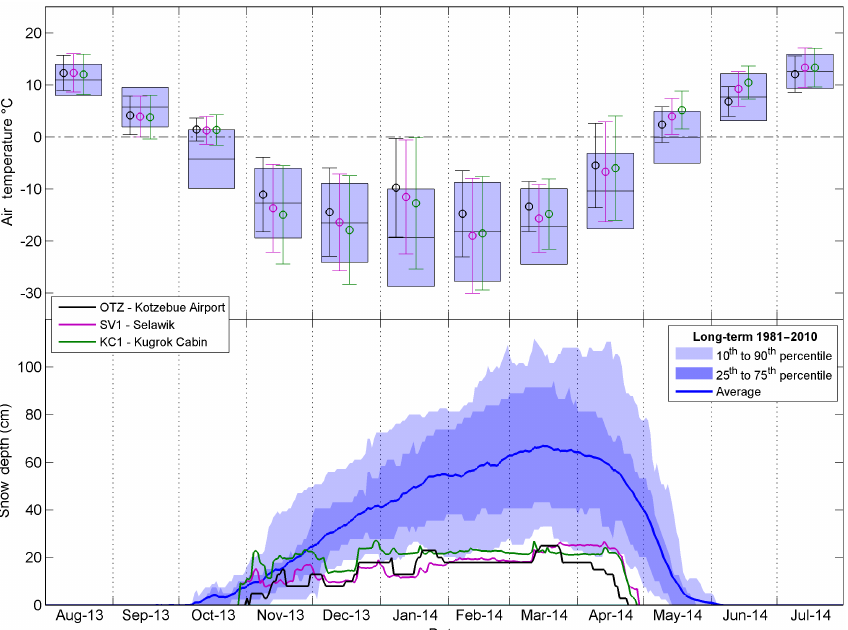
Figure 4. Summary of air temperatures and snow depths for the period August 2013 to July 2014. The top panel shows the mean monthly air temperatures and standard deviations for our core sites and the Kotzebue (OTZ) airport; the blue boxes show the long-term (1981–2010) monthly means and standard deviations from the Kotzebue airport. The bottom panel shows the snow depths on the ground for our core sites and Kotzebue airport, with daily summary statistics for the same long-term period.